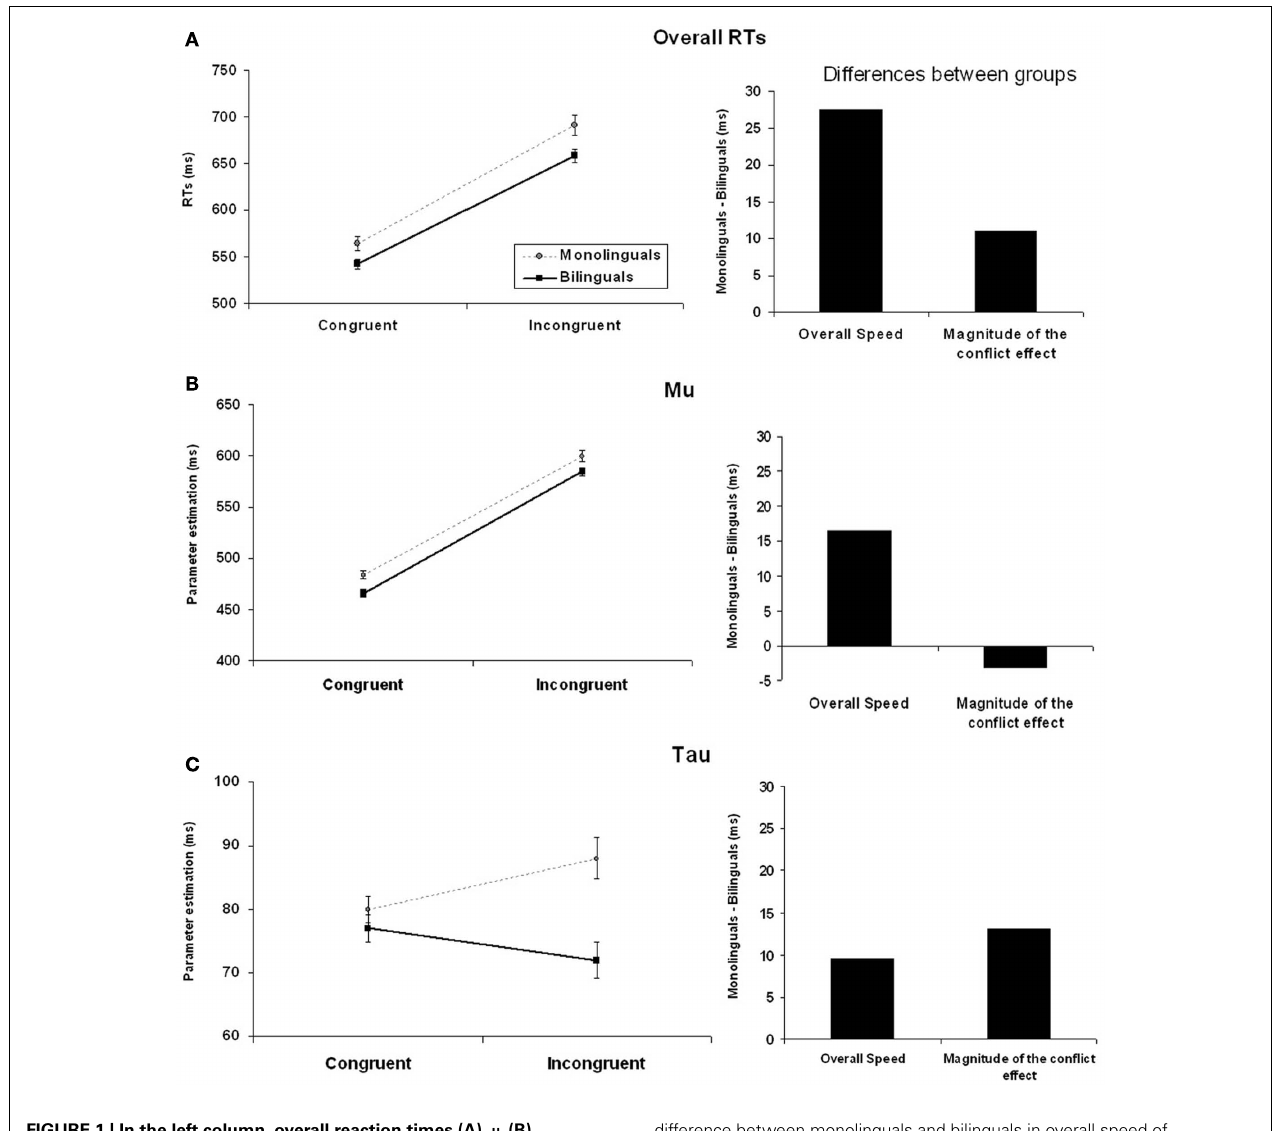
FIGURE 1 | In the left column, overall reaction times (A), μ (B), and τ (C) broken by condition (congruent and incongruent) and group (monolinguals and bilinguals). In the right column,